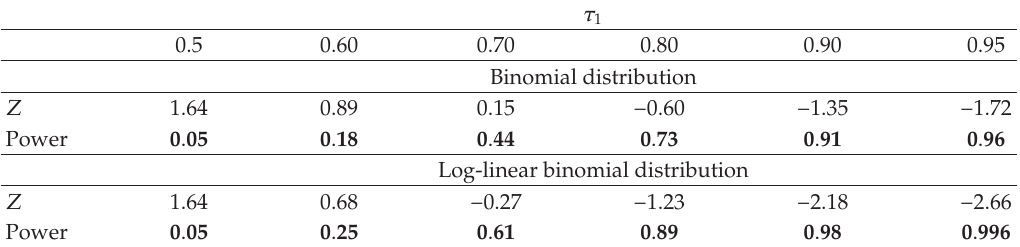
Table 2: Power of the sign test under binomial and log-linear binomial distribution for one-tail test with n (cid:5) 14, ω (cid:5) 1 . 1, and α (cid:5) 0 . 05 based on normal approximation.